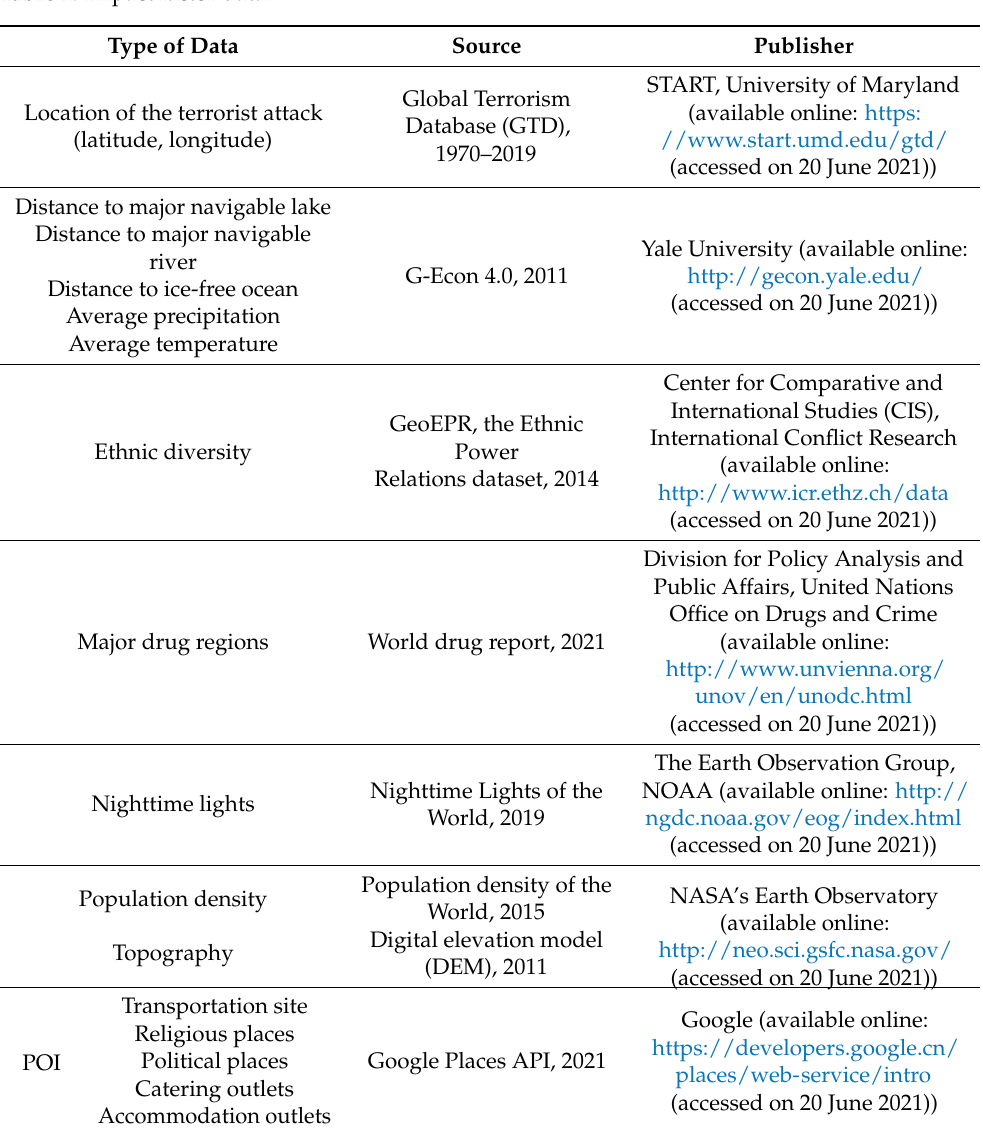
Table 1. Impact factor